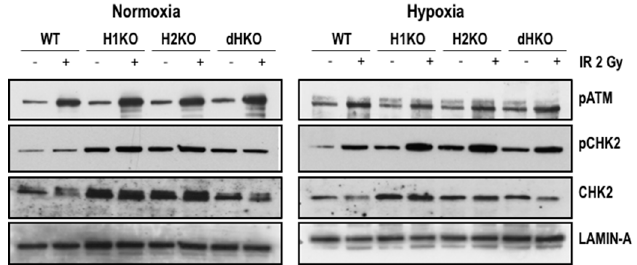
Figure 4. Western blot of pATM, pCHK2 and CHK2 expression in H1299 cells irradiated with 2Gy under normoxic (21%) and hypoxic (0.2%) conditions. Lamin A was used as loading control.